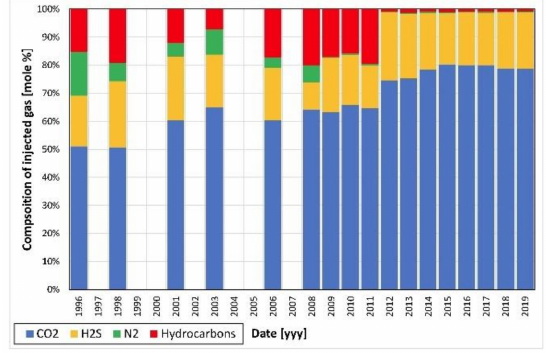
Figure 13. Composition of injected gas.